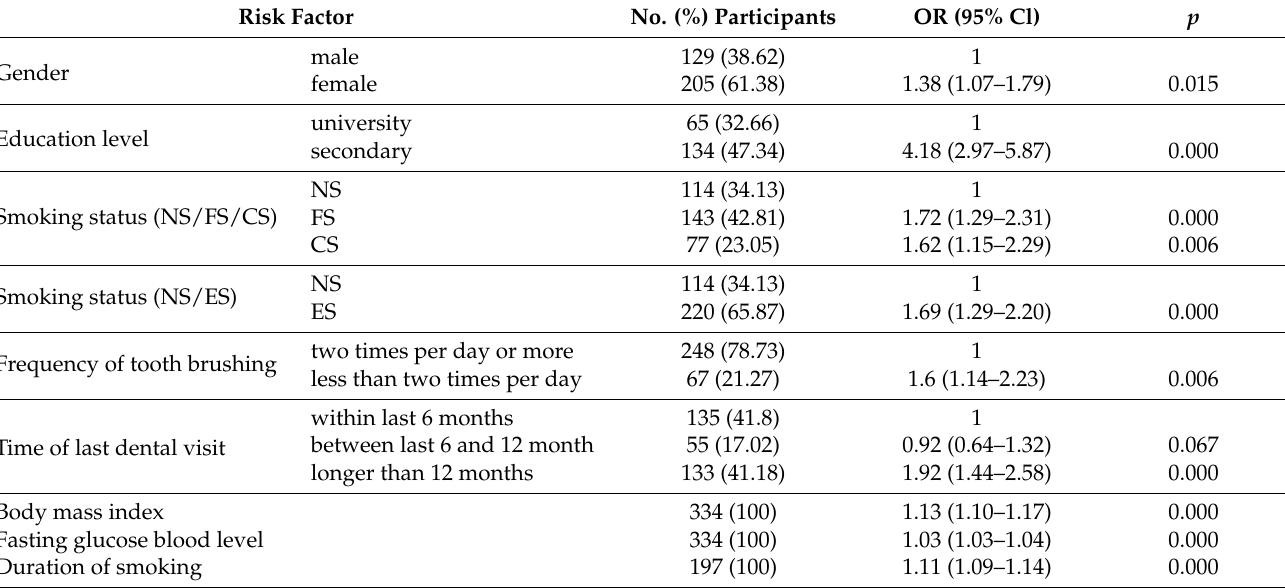
Table 3. Association between risk factors and having more than 8 teeth lost (binary logistic regression, OR—odds ratio, Cl—confidence